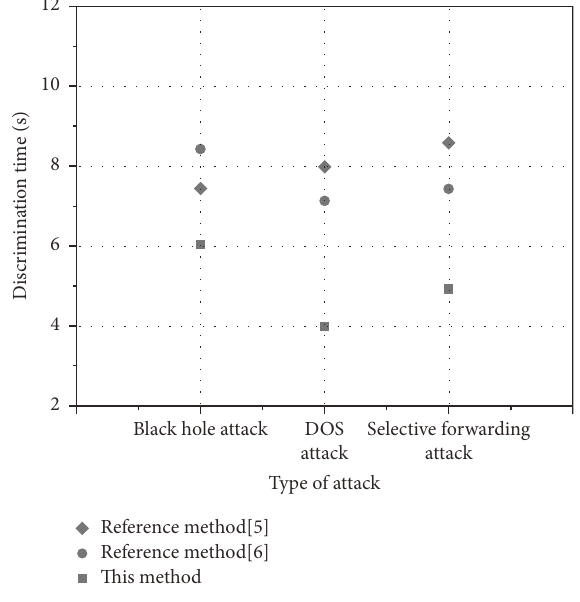
Figure 6: Discrimination of the attack